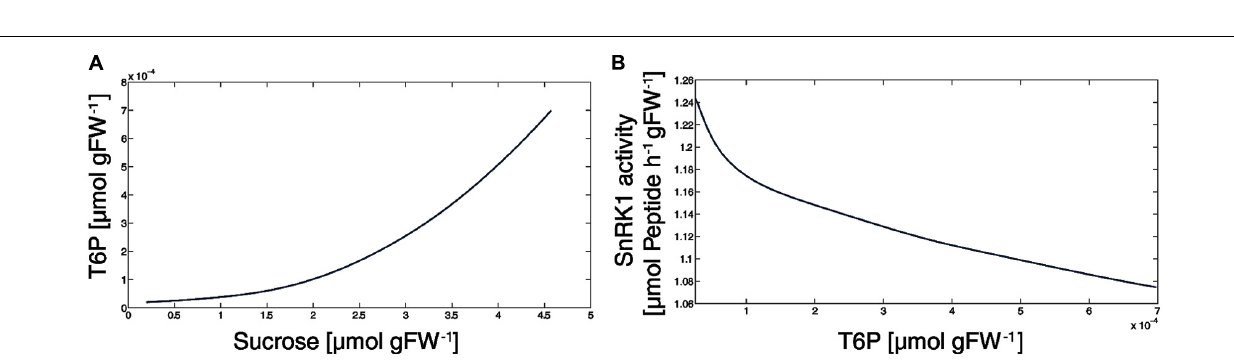
FIGURE 6 | SnRK1 kinetics under various physiological conditions. Simulations of SnRK1 kinetics were performed solving equation (1) with the simulated levels of metabolic inhibitors as they are presented in Figure 3 .